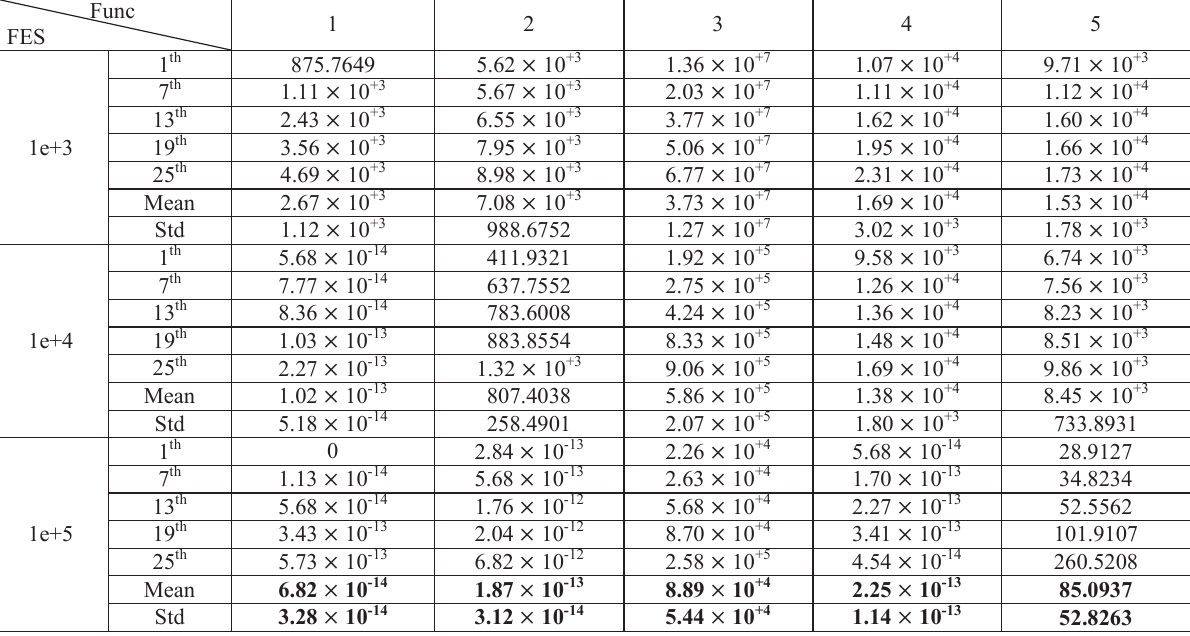
Table 21. Error values achieved at FEs=1e+3, 1e+4, 1e+5 for functions of CEC